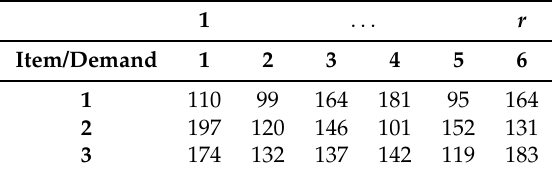
Table 1. Demands per item and period for the original planning horizon.